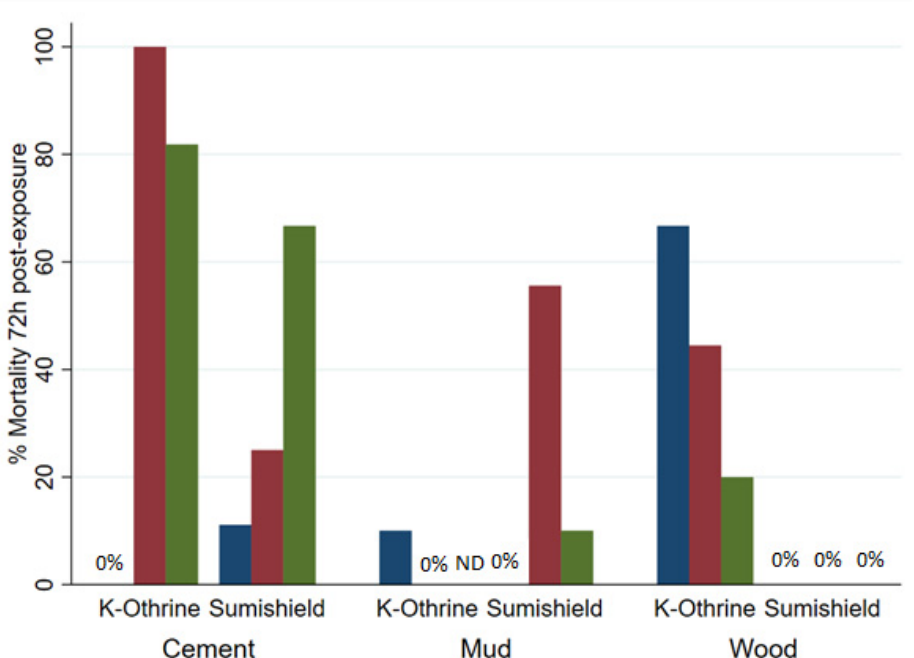
Figure 5. Mortality of Culex quinquefasciatus exposed to different surface types treated with K-Othrine ® WG250 and SumiShield TM 50WG. Mosquitoes were exposed for 30 min in a WHO cone bioassay 9 months after surfaces were treated. Results represent 3 replicates (blue, red, and green bars) of each surface type, except for deltamethrin-treated mud, where one tile was used to replace a broken tile in the main experiment, and the results of only two replicates are shown.